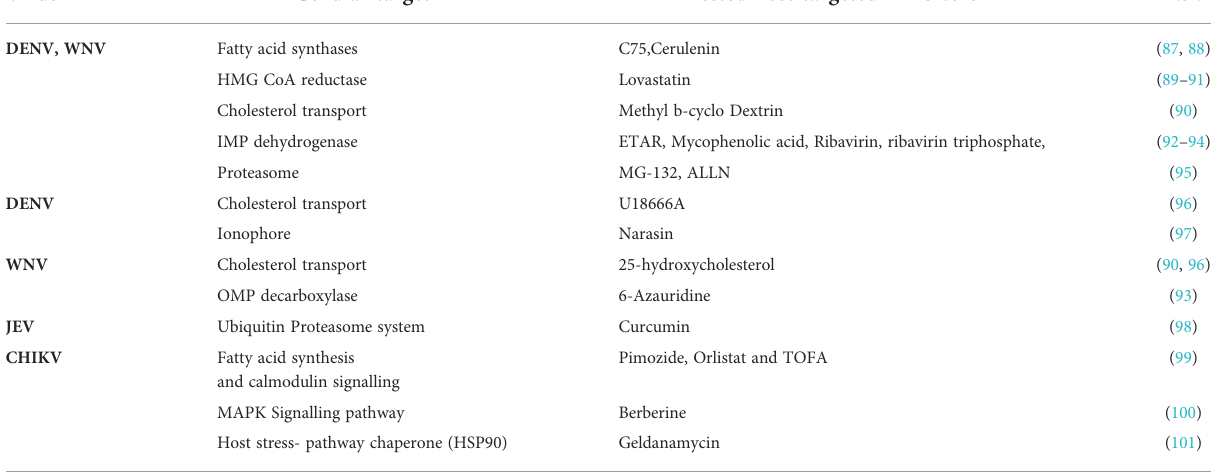
TABLE 3 List of host targeting drugs against different arbovirus.